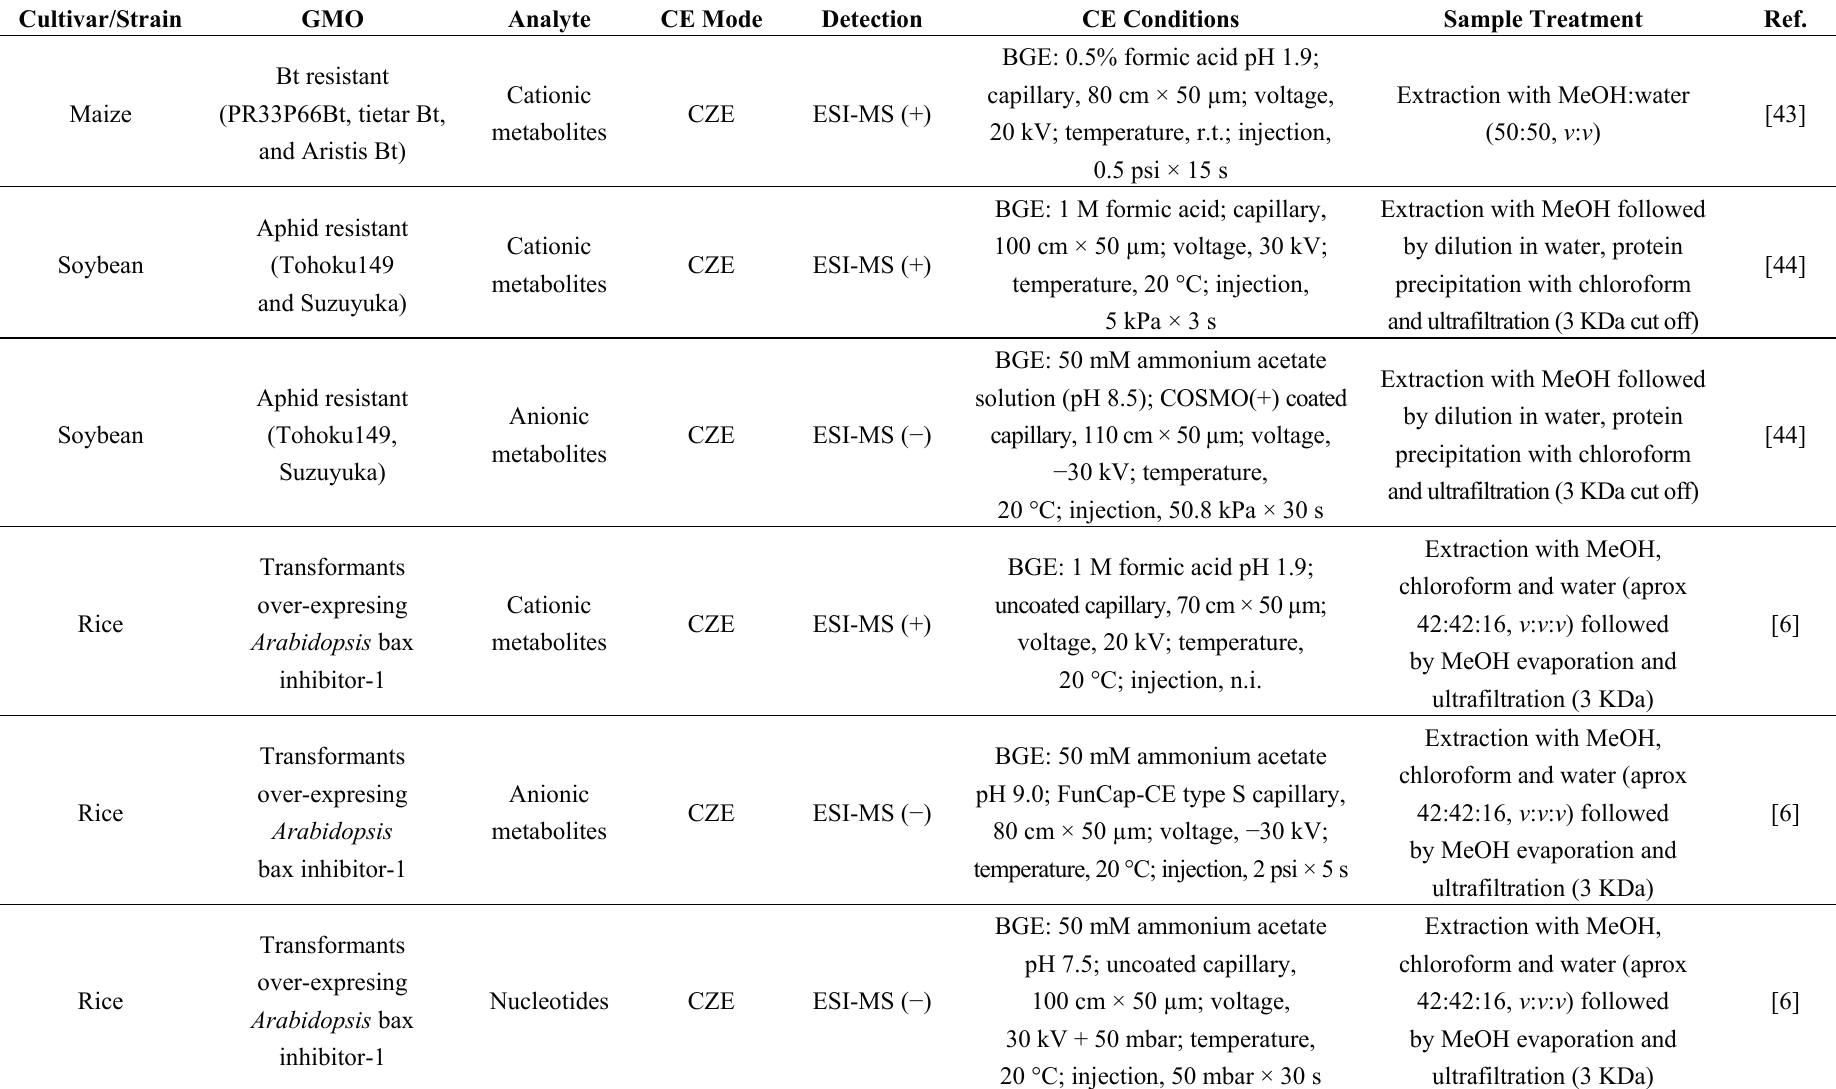
Table 3. Applications of CE for the determination of metabolites in transgenic